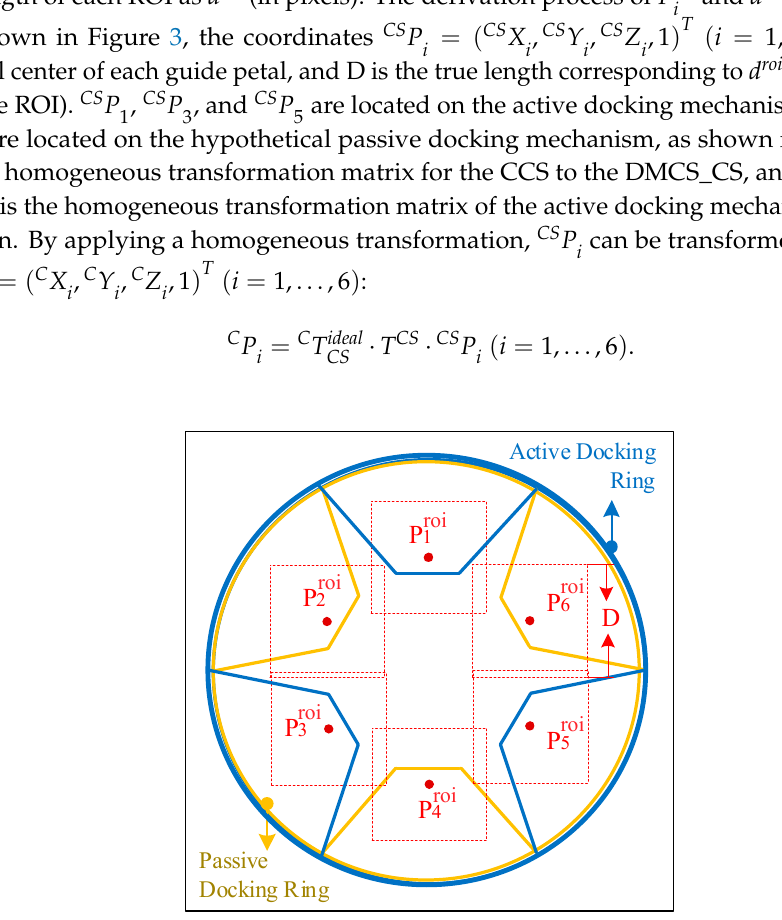
Figure 6. A simplified diagram of the camera viewpoint when the active docking mechanism is in the initial position.